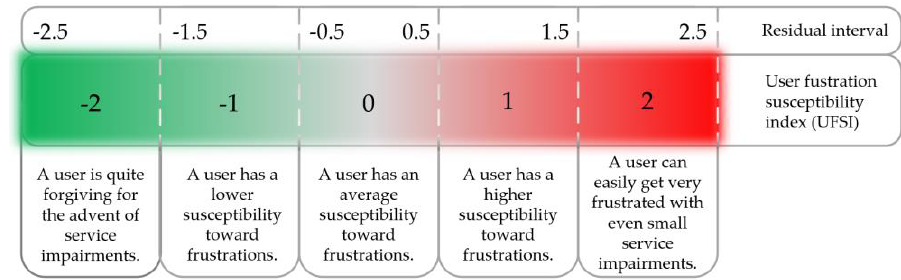
Figure 5. User frustration susceptibility index.